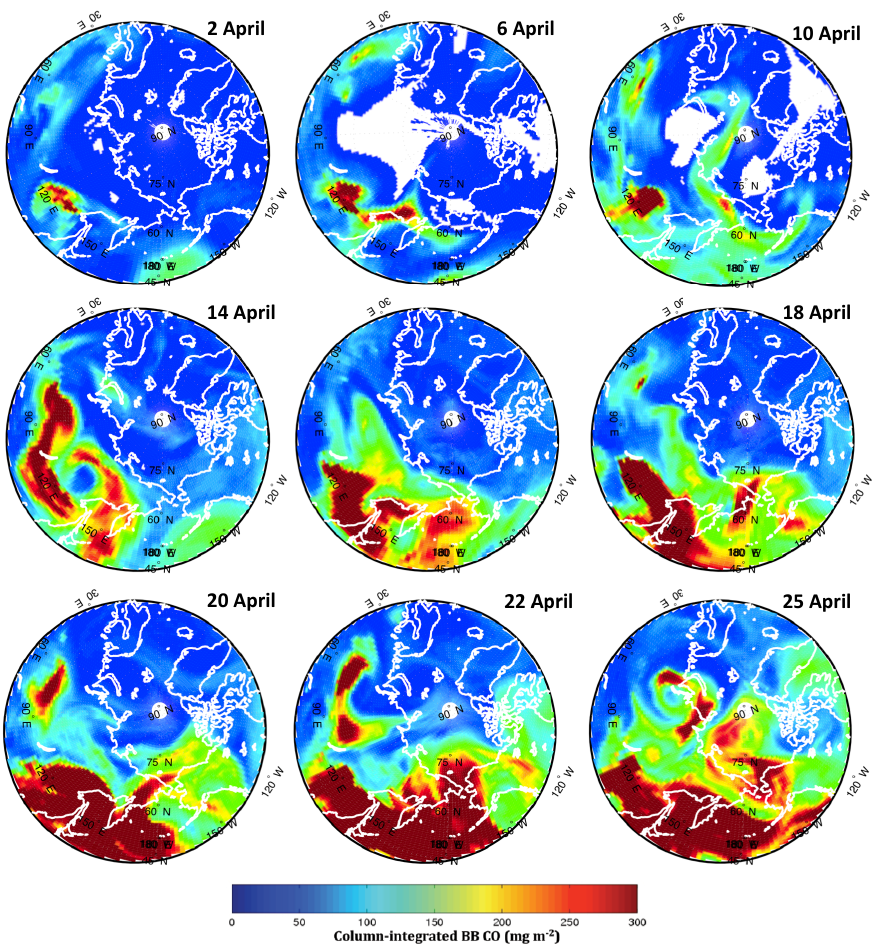
Fig. 10. Flexpart transport model simulations of a 20-day conserved CO tracer emitted by BB sources. These perturbations lie on top of a large CO background from other sources, primarily anthropogenic, of ∼ 900mgm − 2 (not